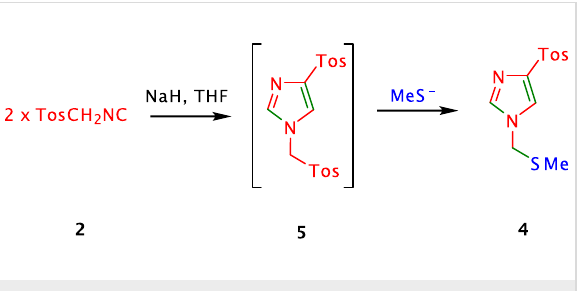
Scheme 2: Base induced dimerization of TosMIC to furnish imidazole 4 .